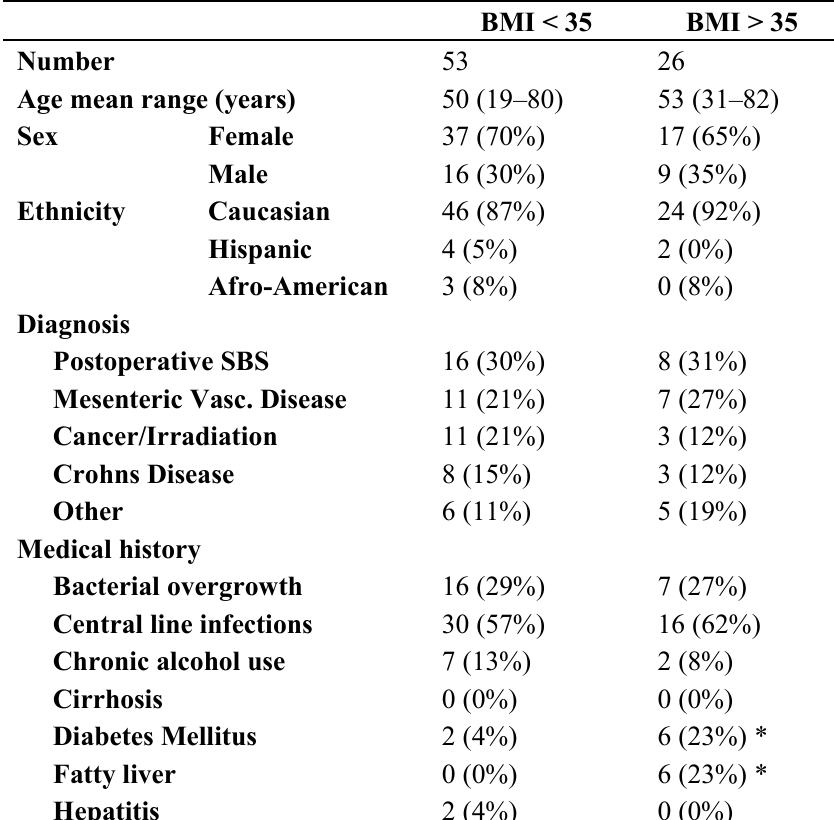
Table 1. Comparison of patient